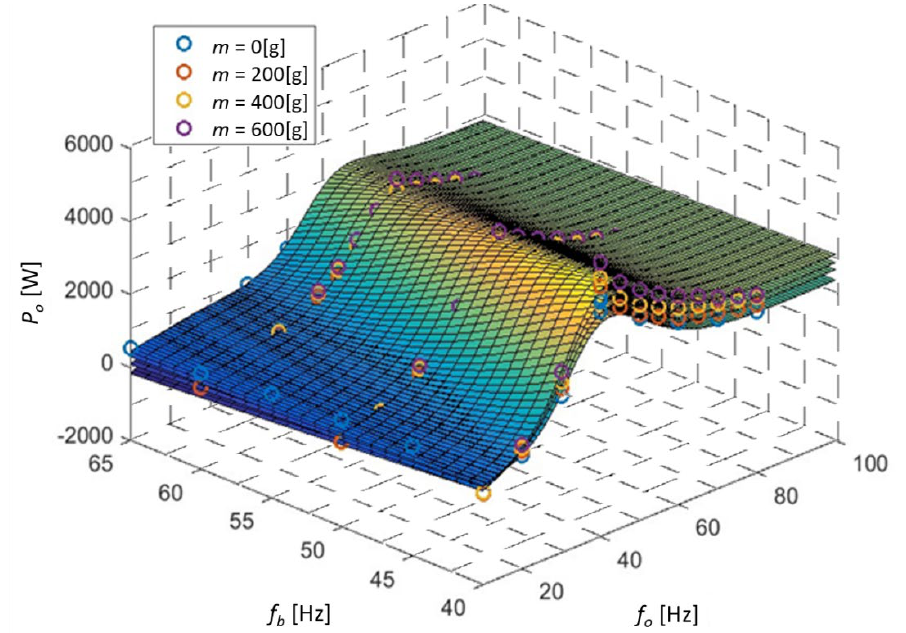
Figure 9. Approximation of the static active power characteristic of the mill depending on the grinding medium mass.